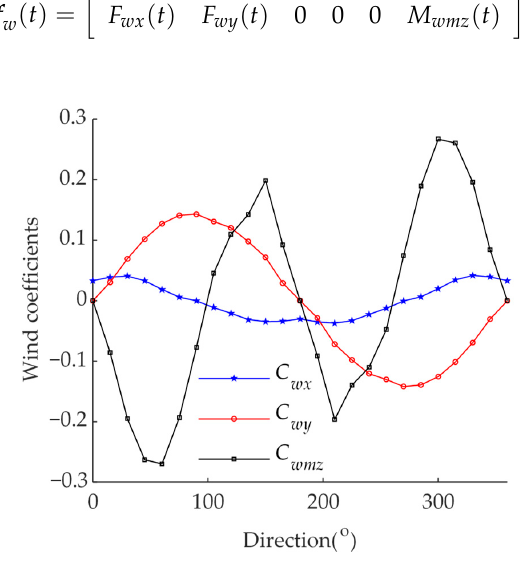
Figure 5. The wind coefficients for HYSY201.